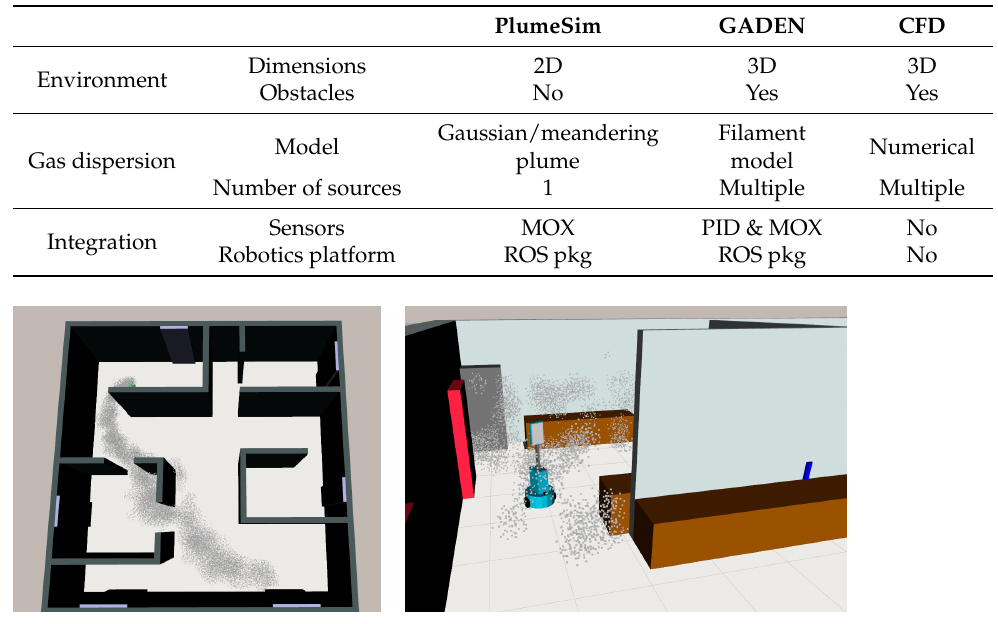
Figure 2. Currently, the results of GADEN simulations have only been integrated for visualization with Rviz. Despite its clarity for user feedback, this visualization does not allow for a high degree of realism and is not suitable for testing image-based